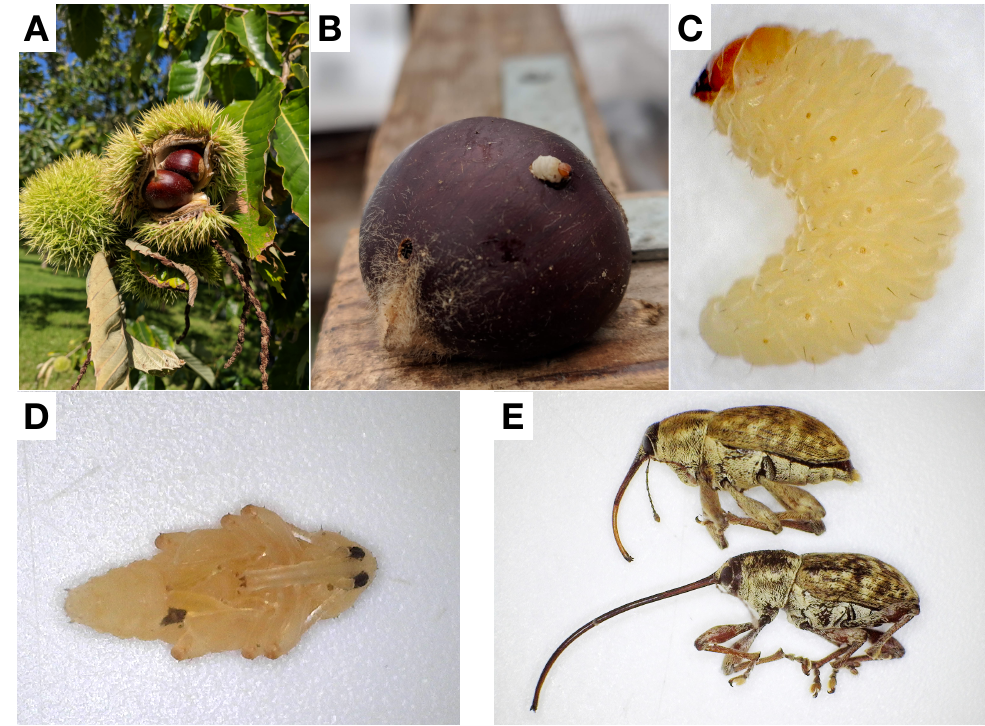
Figure 3. The lesser chestnut weevil ( C. sayi ) lifecycle. ( A ) C. sayi adult females lay eggs in chestnuts (depicted in their burrs). ( B ) C. sayi larvae feed inside the nut and, when they reach their last instar, create a hole and emerge from the chestnut. ( C ) C. sayi larvae emerge out of the holes and fall to the ground, where they burrow to about 5 cm below the soil line. ( D ) C. sayi pupate in the soil (extracted pupae depicted). ( E ) C. sayi pupae then eclose. Males (above with shorter rostrum) and females (below with longer rostrum) then emerge from the soil to continue the